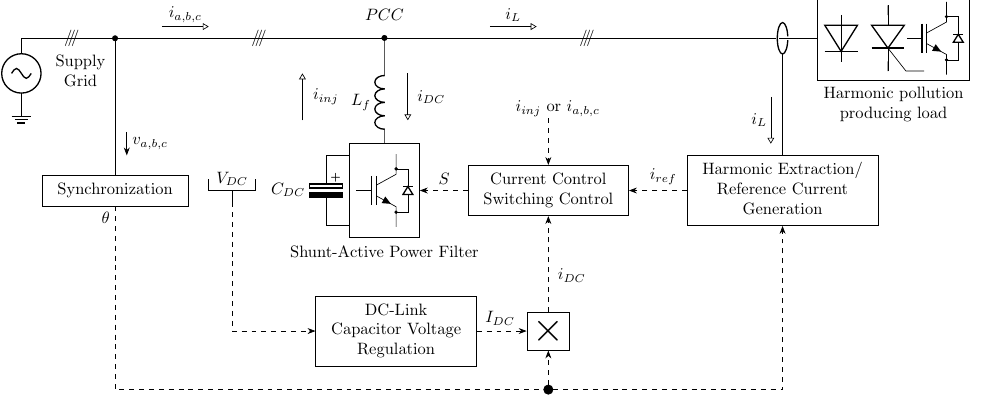
Figure 1. Simplified block diagram and working principle of